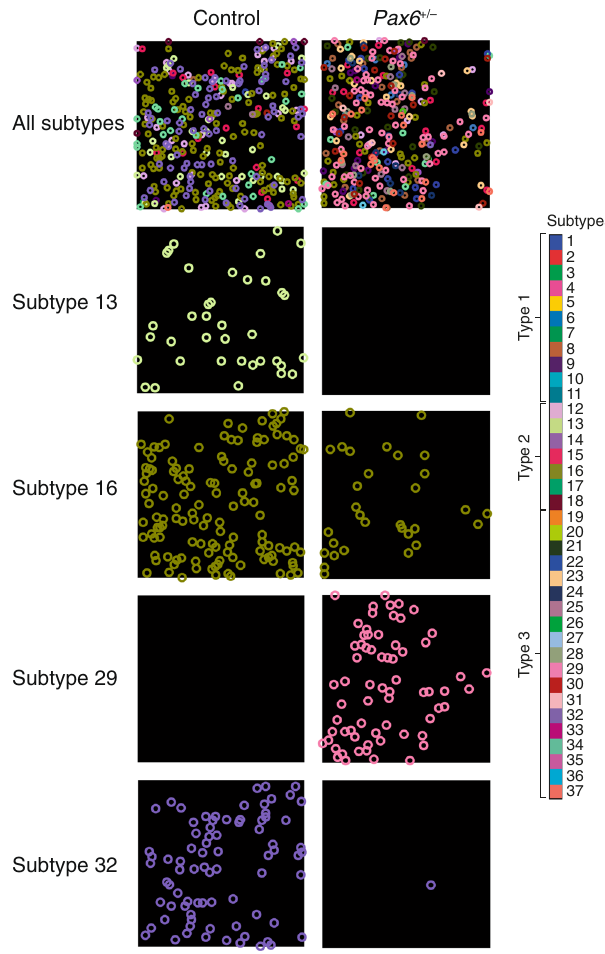
Fig. 3 | Synapse composition is altered during the synaptome phenotype waves. Exemplar puncta spatial distributions of synapse subtypes in single tile images(area21×21 µ m)ofP7control(left)and Pax6 +/ − (right)mousebrain.Whereas the overall puncta density is unchanged, individual synapse subtypes, and there- fore the overall subtype composition, are signi fi cantly affected by the Pax6 +/ −